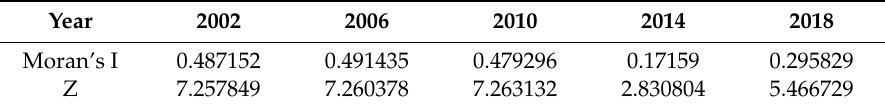
Table 4. The global Moran’s I values of Chinese citizens’ health index.